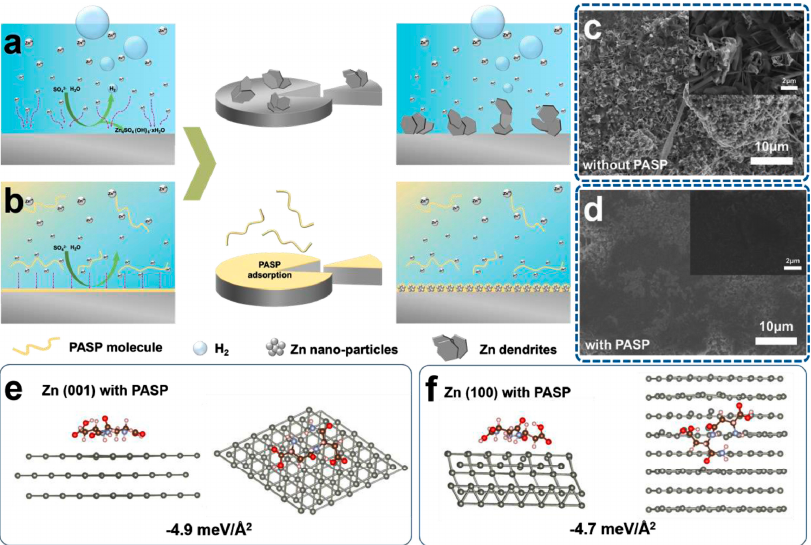
Figure 10. Schematic illustration for the metal Zn deposition process in the electrolyte ( a ) without or ( b ) with PASP additive. The surface of the Zn metal anode deposited at 1 mA cm − 2 with capacity of 1 mAh cm − 2 ( c ) without or ( d ) with PASP additive. ( e , f ) Comparison of the surface energies for the Zn (001) and Zn (100) after PASP adsorption. Reproduced with permissions from Ref. [95].